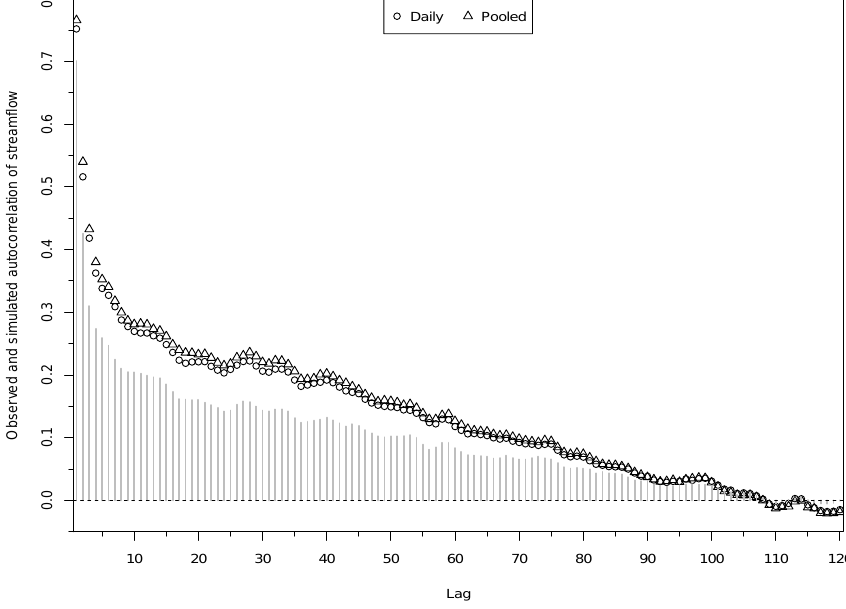
Figure 5. Observed autocorrelation of daily streamflow, in gray, with simulated autocorrelations from daily and pooled ordinary kriging daily streamflow time